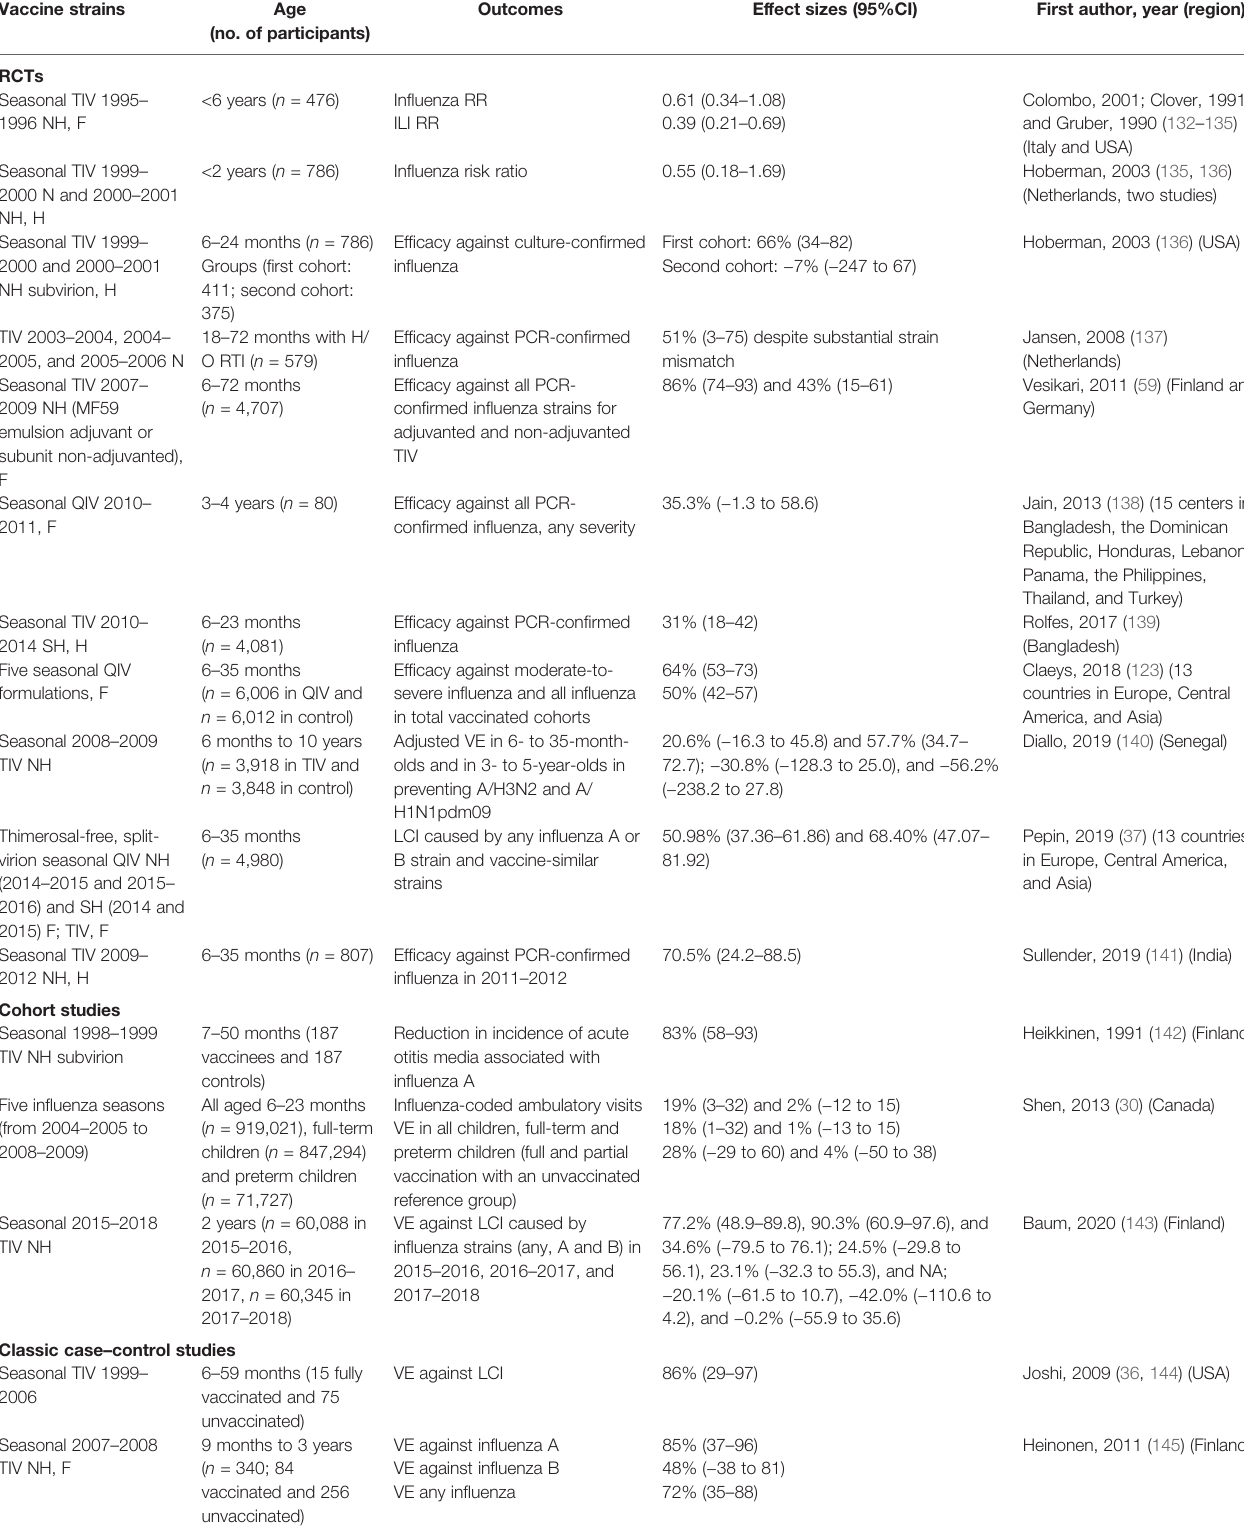
TABLE 2 | Vaccine ef fi cacy and effectiveness of in fl uenza vaccination in healthy children under 5 years of age. Vaccine strains Age (no. of participants)